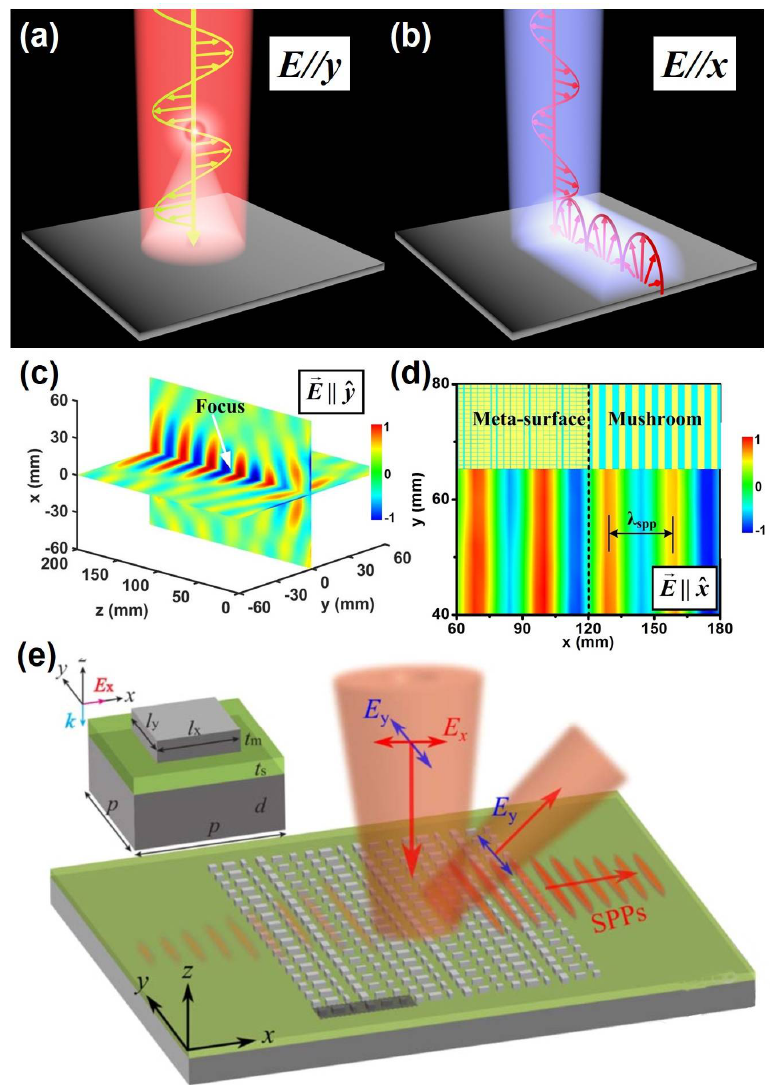
Fig ure 4. A reflective bifunctional metasurfaces that behaves as ( a ) a focusing lens and ( b ) a PW-to- SW ( propagating wave to surface wave) convertor when excited by incident waves with polarizations E // y (red light) and E // x (blue light), respectively. ( c ) Measured Re[(cid:1831)(cid:4652)⃗] distributions on both x o z and y o z planes as the metasurface is illuminated by a normally incident y -polarized plane wave. ( d ) Measured Re[(cid:1831)(cid:4652)⃗] pattern on the xy -plane using a monopole antenna placed vertically and 8 mm above the metasurface and the mushroom structure, when the metasurface is illuminated by a normally incident x -polarized plane wave. Reproduced from [93] with permission. ( e ) The working principle of similar type of bi-functional metasurface operating for visible light realized in [94]. The top panel shows the schematic of the unit cell consisting of an Ag nanobrick (grey) on top of a spacer (green) and Ag substrate. Reproduced from [94] with permission. SPPs, surface plasmon